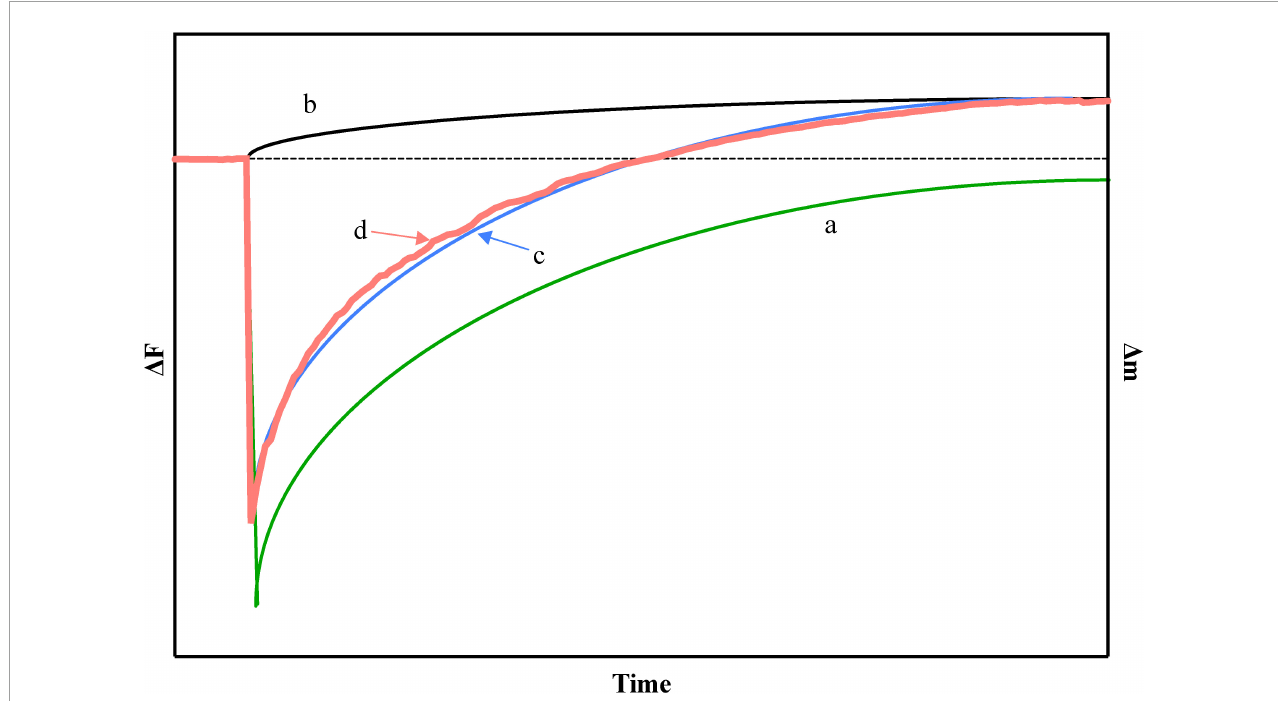
FIGURE3 (a) In theory, the relationship between the generation of [ES] and time, (b) in theory, the relationship between the generation of [P] and time, (c) in theory, the relationship with time in the case of simultaneous generation of [ES] and [P], and (d) the actual experimental curve on quartz crystal